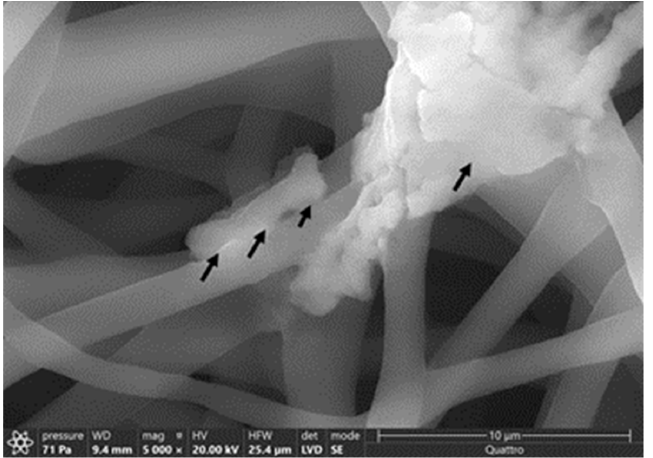
Figure 11. Interaction between M. smegmatis and PCL_Fulbright nanofiber. Black arrows are pointing to the bacterial cell attached to the nanofiber.